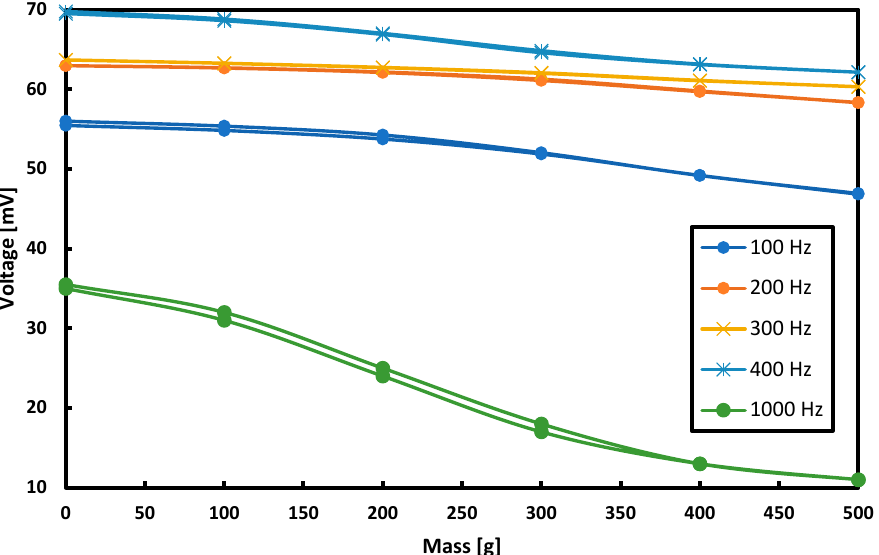
Figure 11. Hysteresis curves for: ( a ) voltage, ( b ) noise, ( c ) phase shift, and ( d ) magnetic flux meas- urements depending on the weight loading the plate.